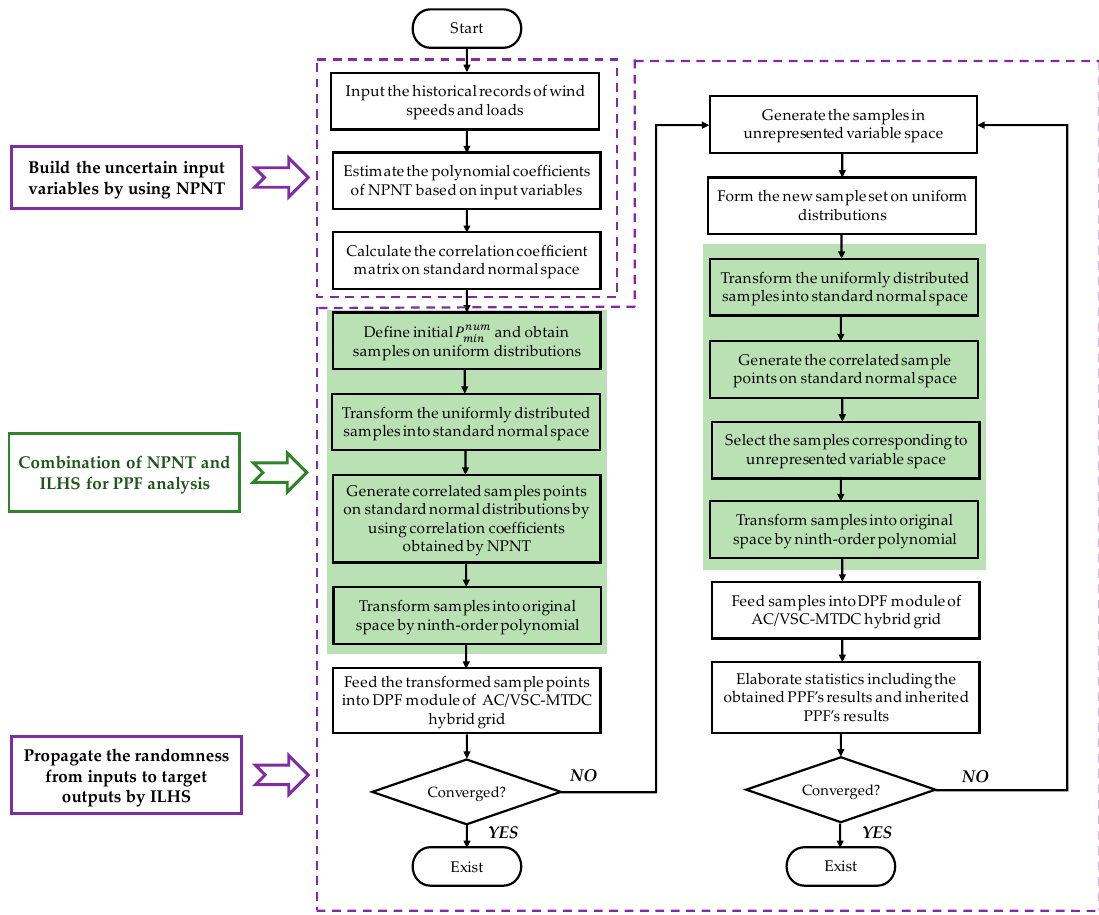
Figure 5. The flow chart of combining ninth-order polynomial normal transformation (NPNT) and ILHS for probabilistic power flow (PPF) analysis on the AC/DC grid.